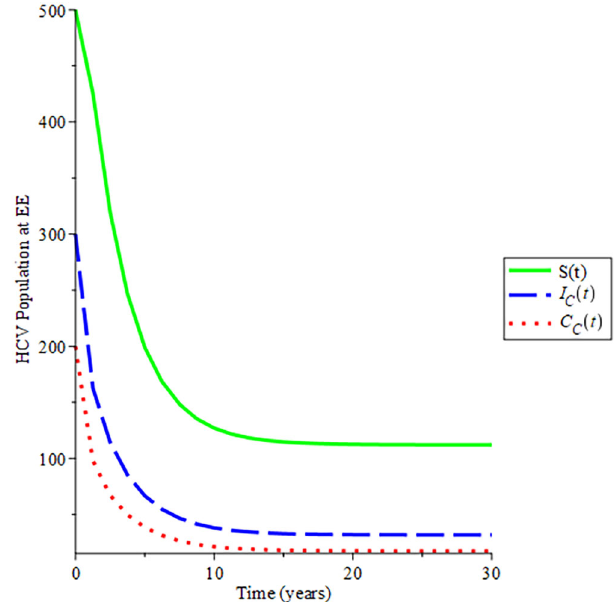
Figure 5. Proportion of different population of HCV at EE when R 0 >